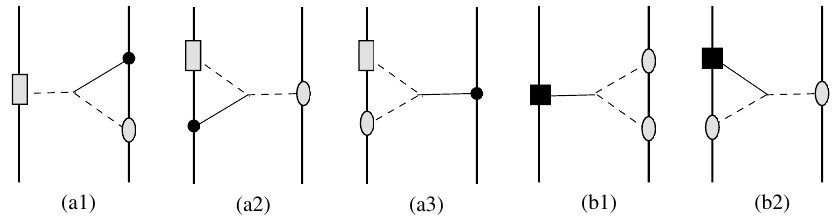
Figure 4 . The Feynman graphs with cubic self-gravitational interaction, i.e. at one-loop level, at the NLO quartic-in-spin interaction. There are no vertices with time dependence here, similar to the NLO quadratic-in-spin sector of even-parity [14]. These graphs contain all possible interactions among the mass, spin and spin-induced multipoles up to the